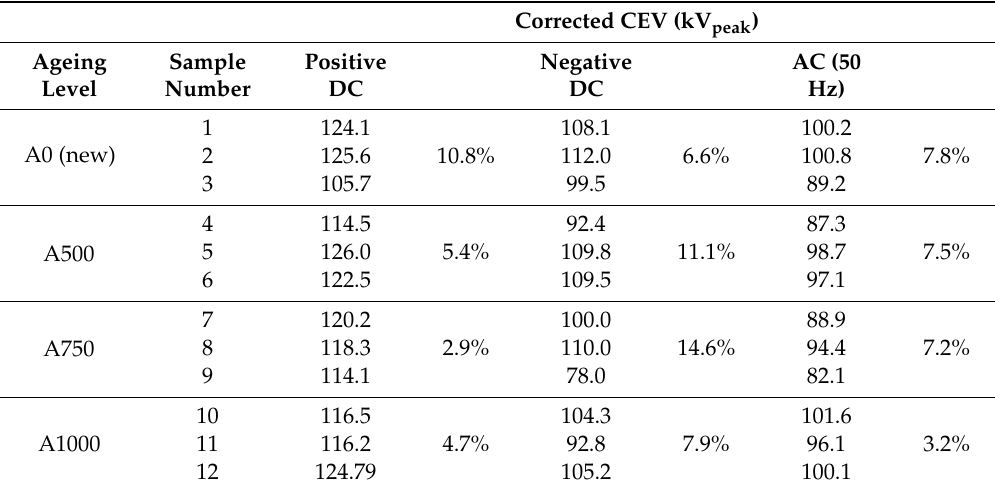
Table 5. T-type S-line connectors. Corrected CEV